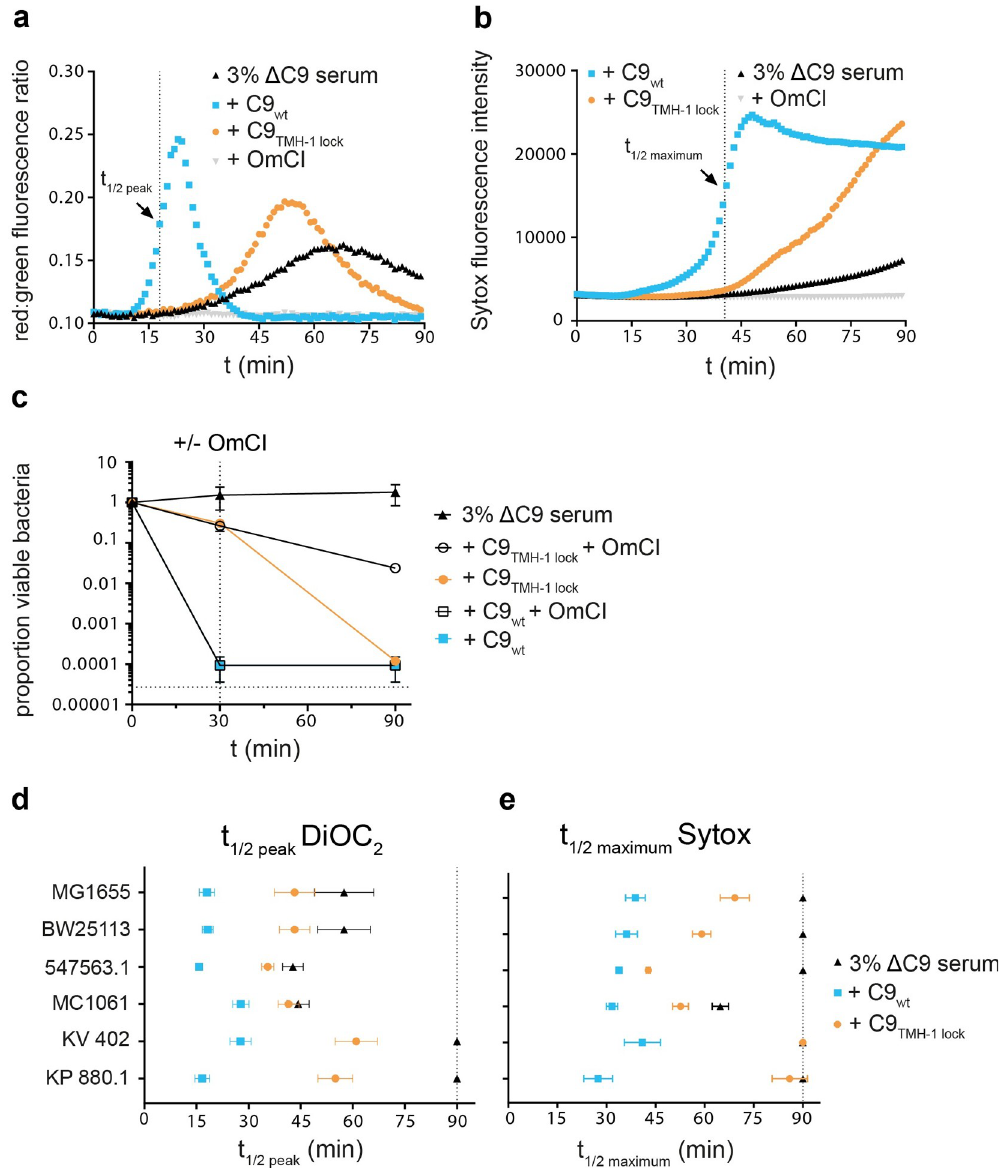
Fig 5. Polymerization of C9 enhances bacterial cell envelope damage and killing in serum. E . coli MG1655 was incubated in 3% C9-depleted serum supplemented with a physiological concentration (= 25 nM) of C9 wt or C9 TMH-1 lock for 90 minutes. As negative control, 25 μ g/ml C5 conversion inhibitor OmCI was added to the serum. a) OM damage was measured by DiOC 2 influx, which was determined by the shift in red:green fluorescence ratio over time in a multiwell plate-reader assay. b) IM damage was measured by Sytox influx over time in a multiwell plate-reader assay. c) Bacterial viability was determined at different time points by counting colony forming units (CFU’s) and calculating the proportion of viable cells compared to t = 0. At t = 30 (vertical dotted line), buffer was added (closed symbols) or OmCI (open symbols) to stop MAC formation. The horizontal dotted line represents the detection limit of the assay. d-e) Other E . coli strains (BW25113, MC1061, 547563.1) and K . variicola 402 were also incubated in 3% C9-depleted serum supplemented with C9 wt or C9 TMH-1 lock for 90 minutes. K . pneumoniae 567880.1 was incubated in 10% C9-depleted serum because of less efficient activation of the complement cascade and was therefore also supplemented with 80 nM C9 wt or C9 TMH-1 lock . d) OM damage was represented for all strains by the time when DiOC 2 influx reached half the value of the peak (t 1/2peak , shown in a for C9 wt ). e) IM damage was represented for all strains by the time when Sytox fluorescence reached half the maximum value (t 1/2maximum , shown in b for C9 wt ). Multiwell plate-reader assays (a and b) are shown by one representative experiment that has been repeated at least three times. Data represent mean +/- SD of three independent experiments (c, d and e).